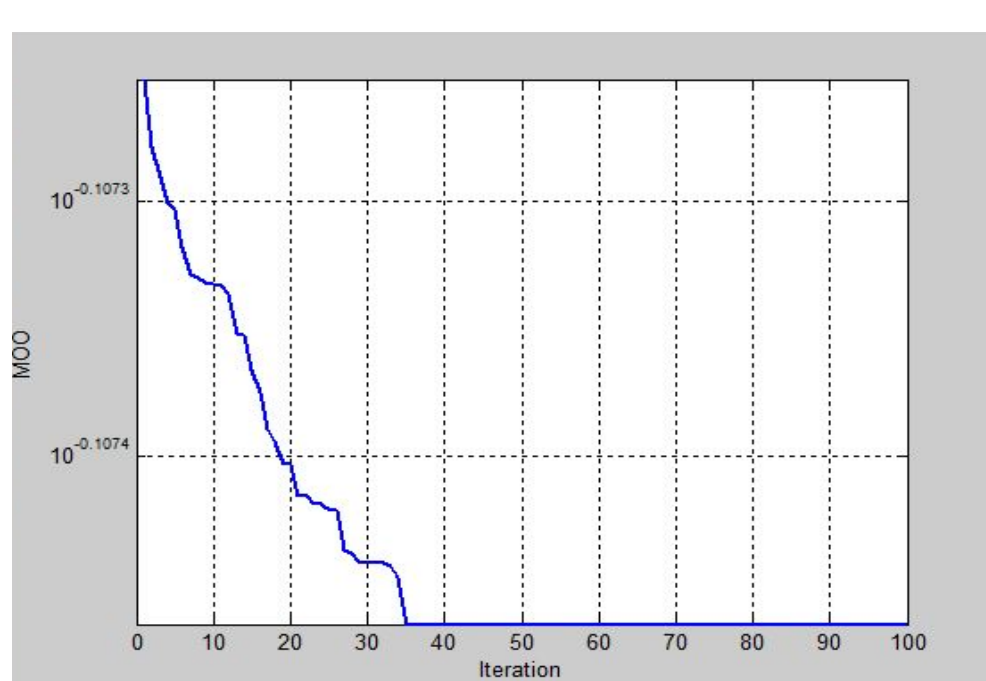
Figure 6. Iteration chart using ABC